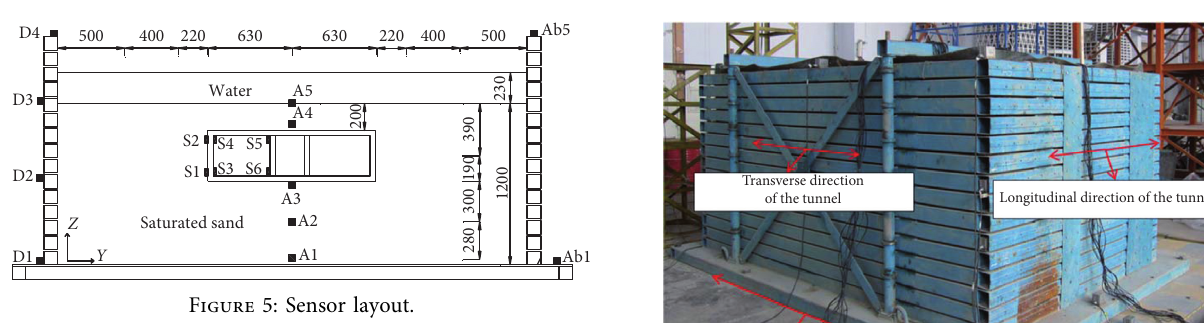
Figure 5: Sensor layout.